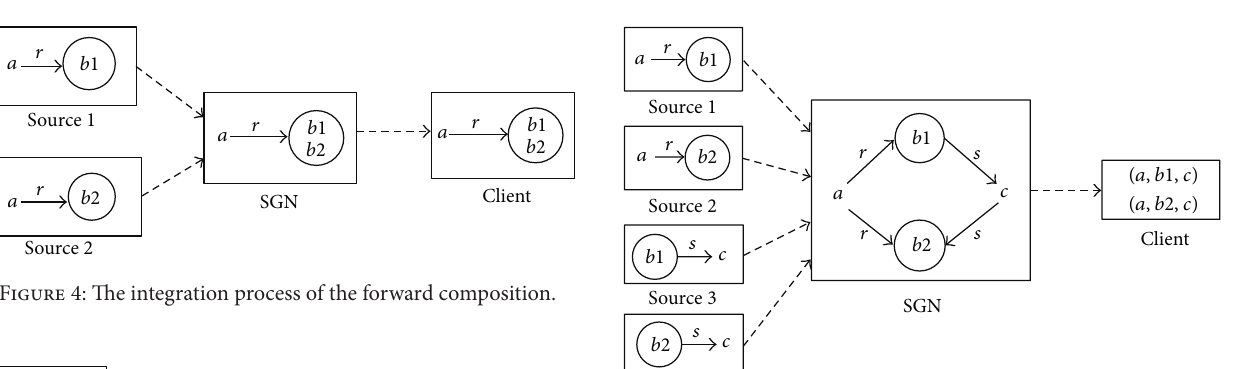
𝑟(𝑎, 𝑏1), 𝑟(𝑎, 𝑏2) will be returned and can be combined at either the SGN or the client.